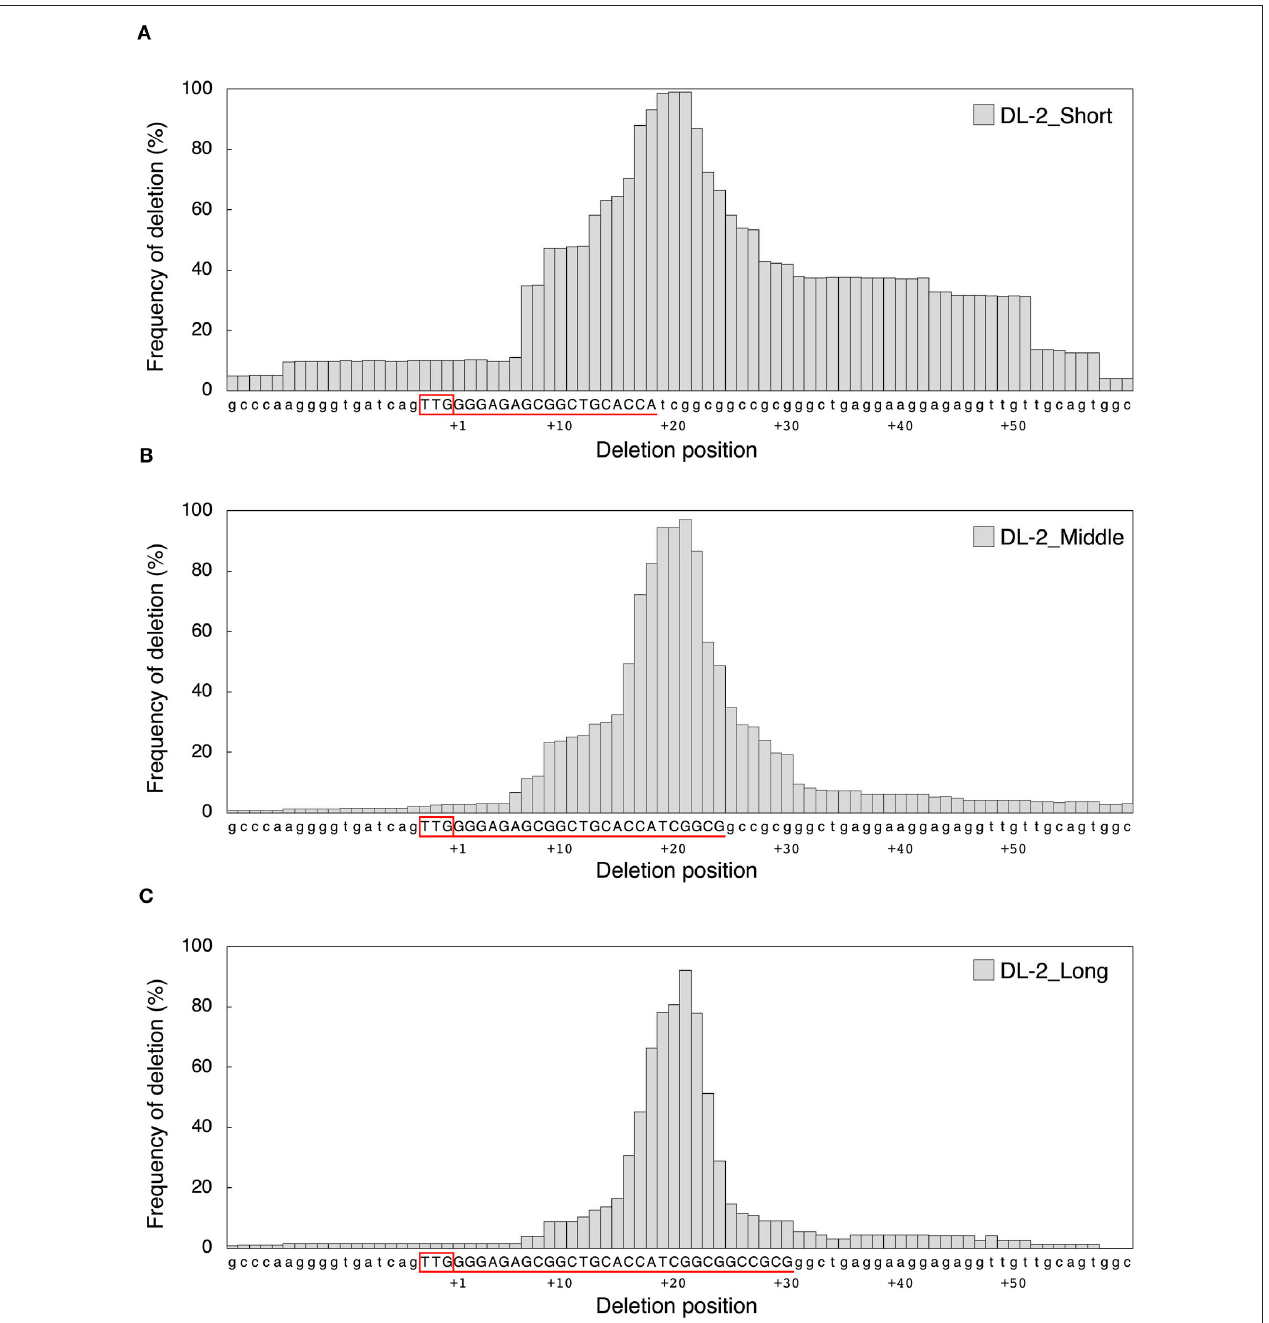
FIGURE 3 | Comparison of deletion position according to the (A) DL2-Short, (B) DL-2_Middle, and (C) DL-2_Long guides at DL-2 target sites. Deletion size and mutation number were detected by targeted amplicon sequencing. Frequency of deletion means the percentage of deletions in each position among all deletion mutations. The target sequence of each guide is shown in red, underlined, and in capital letters. The PAM sequence is boxed in red upstream of the target